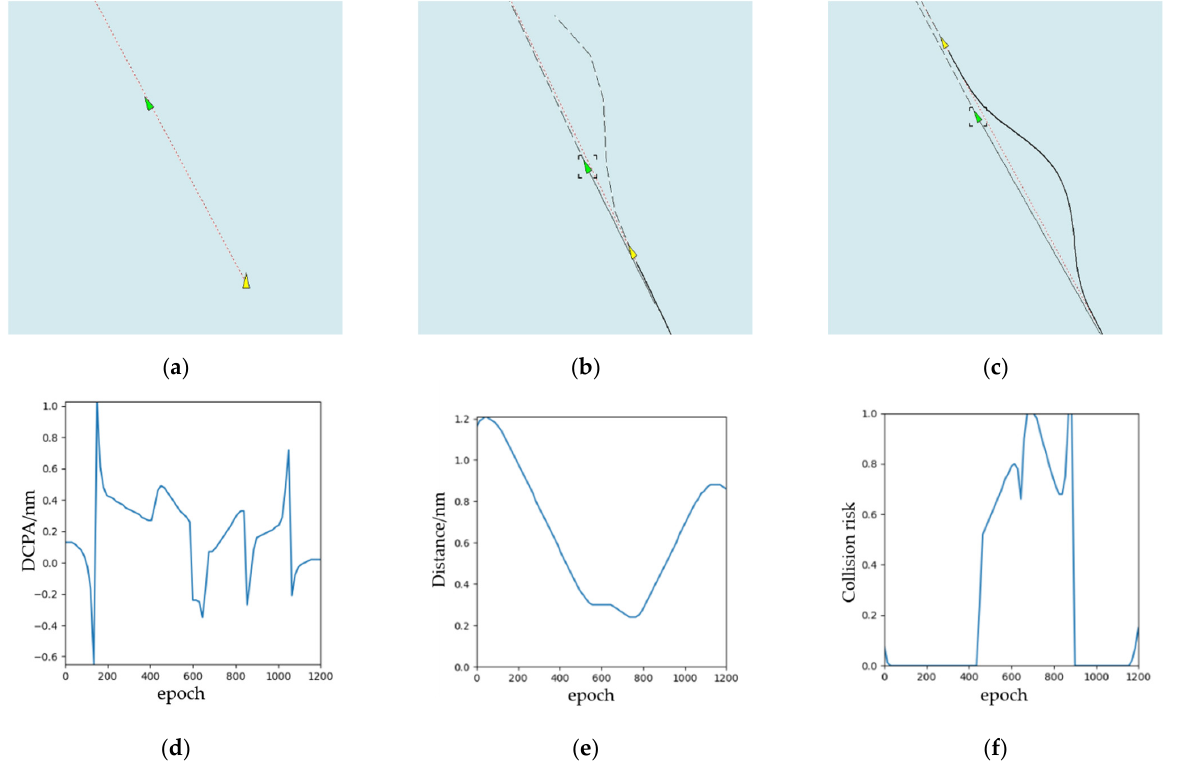
Figure 8. The experimental results (overtaking): ( a ) the start time during the collision avoidance process; ( b ) the middle time during the collision avoidance process; ( c ) the end time during the collision avoidance process; ( d ) DCPA; ( e ) distance; ( f ) collision risk.